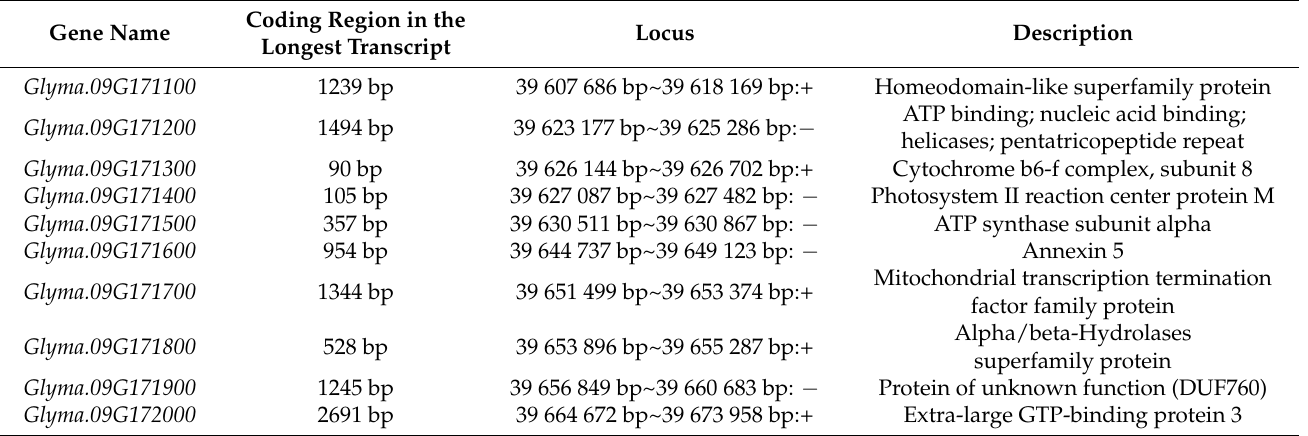
Table 2. Predicted genes and their information in the fine mapping region of Rf3.